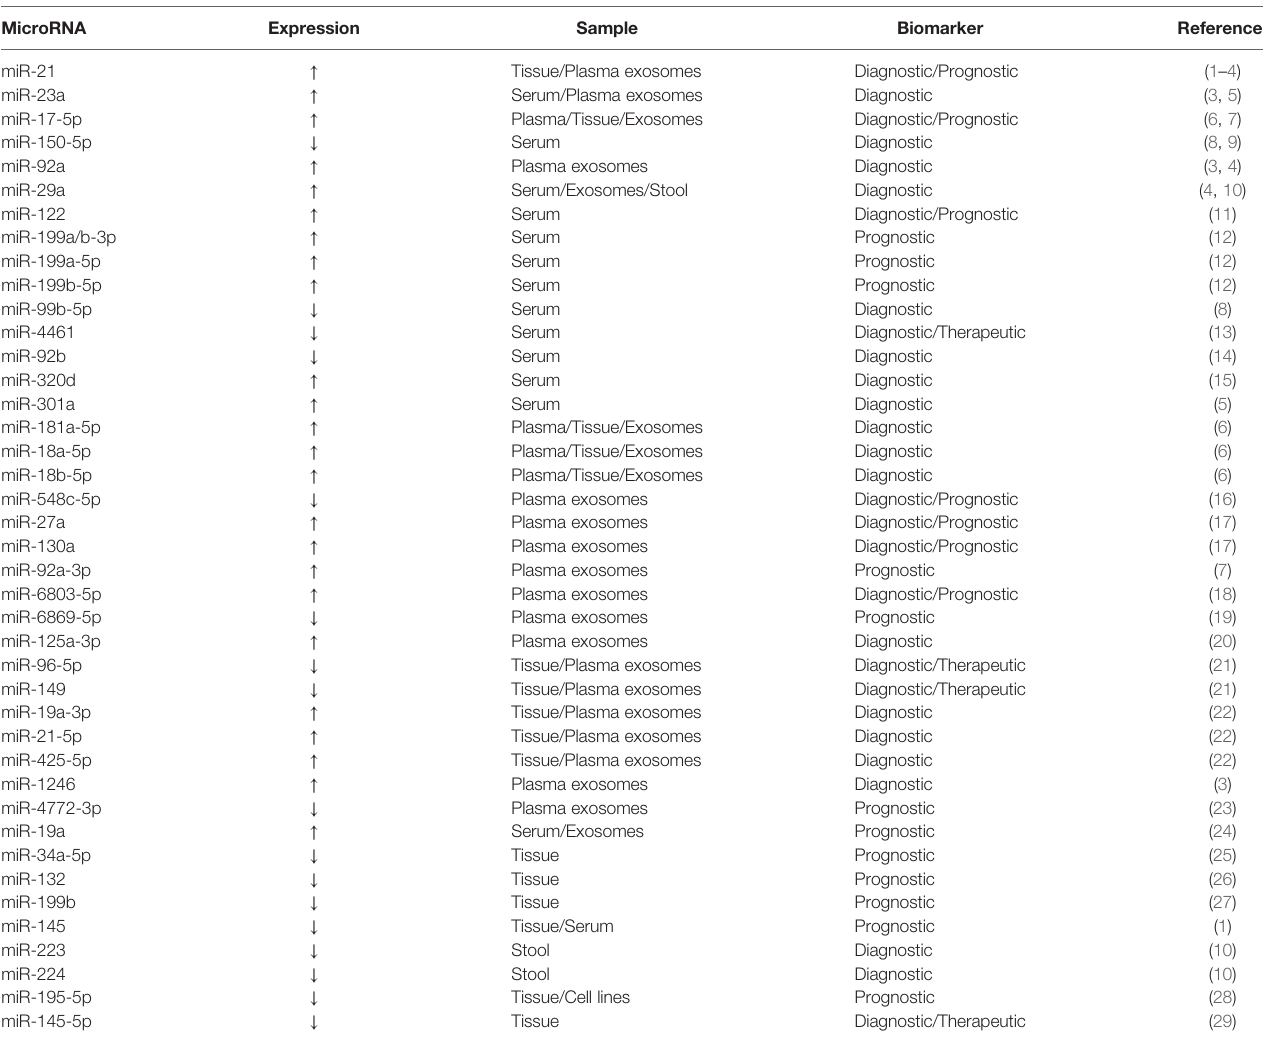
TABLE 1 | MicroRNAs as potential biomarkers for colorectal cancer.